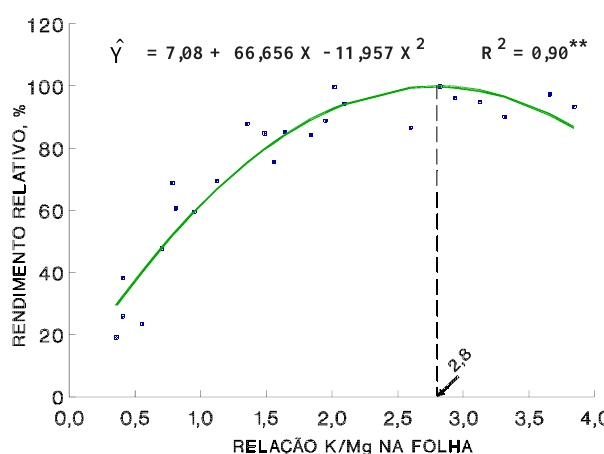
Figura 6. Rendimento relativo de soja em função da relação K/Mg no tecido foliar de soja.